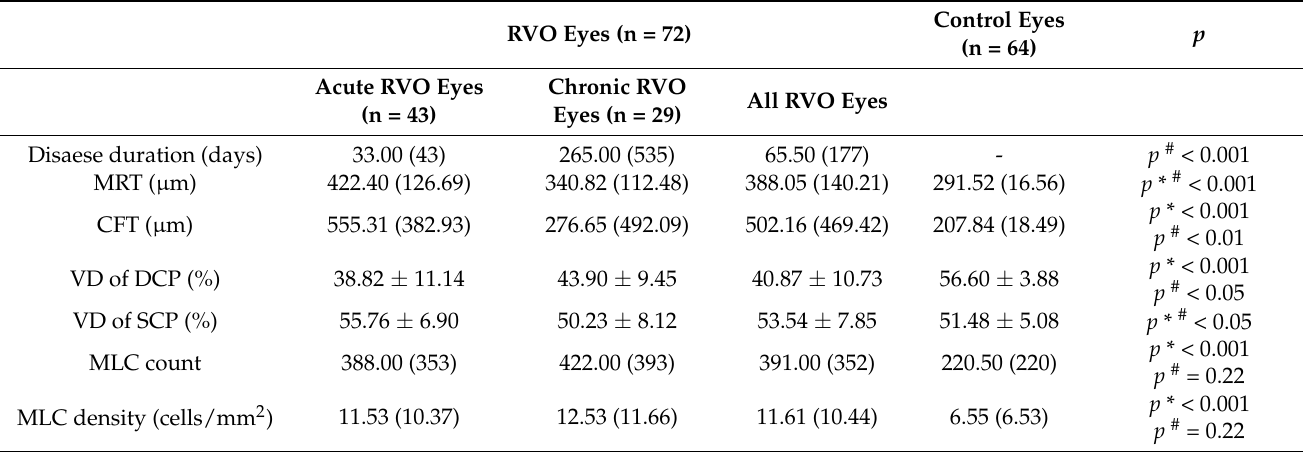
Table 2. OCTA parameters and MLC count in RVO eyes and control